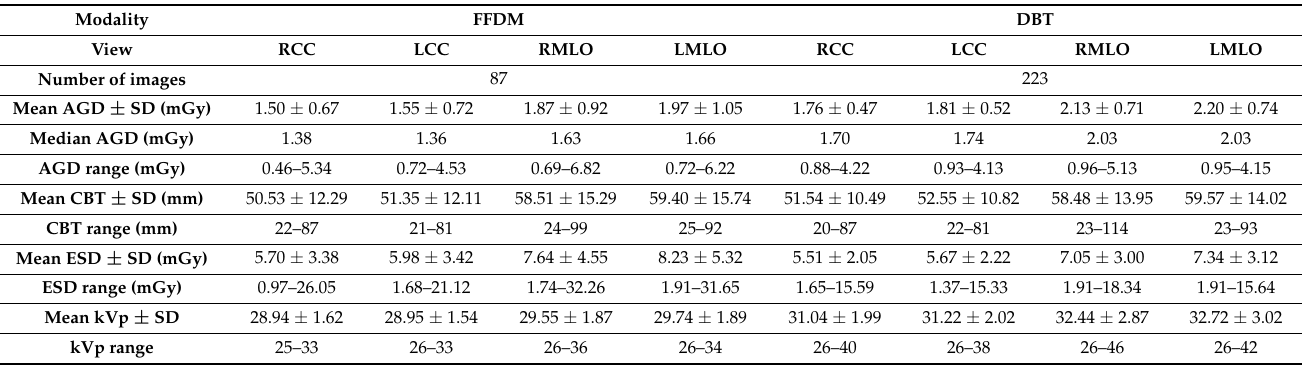
Table 4. The mean, median, minimum and maximum values for AGD, CBT, ESD, and kVp for all mammographic projections in full-field digital mammography (FFDM) and digital breast tomosyn-